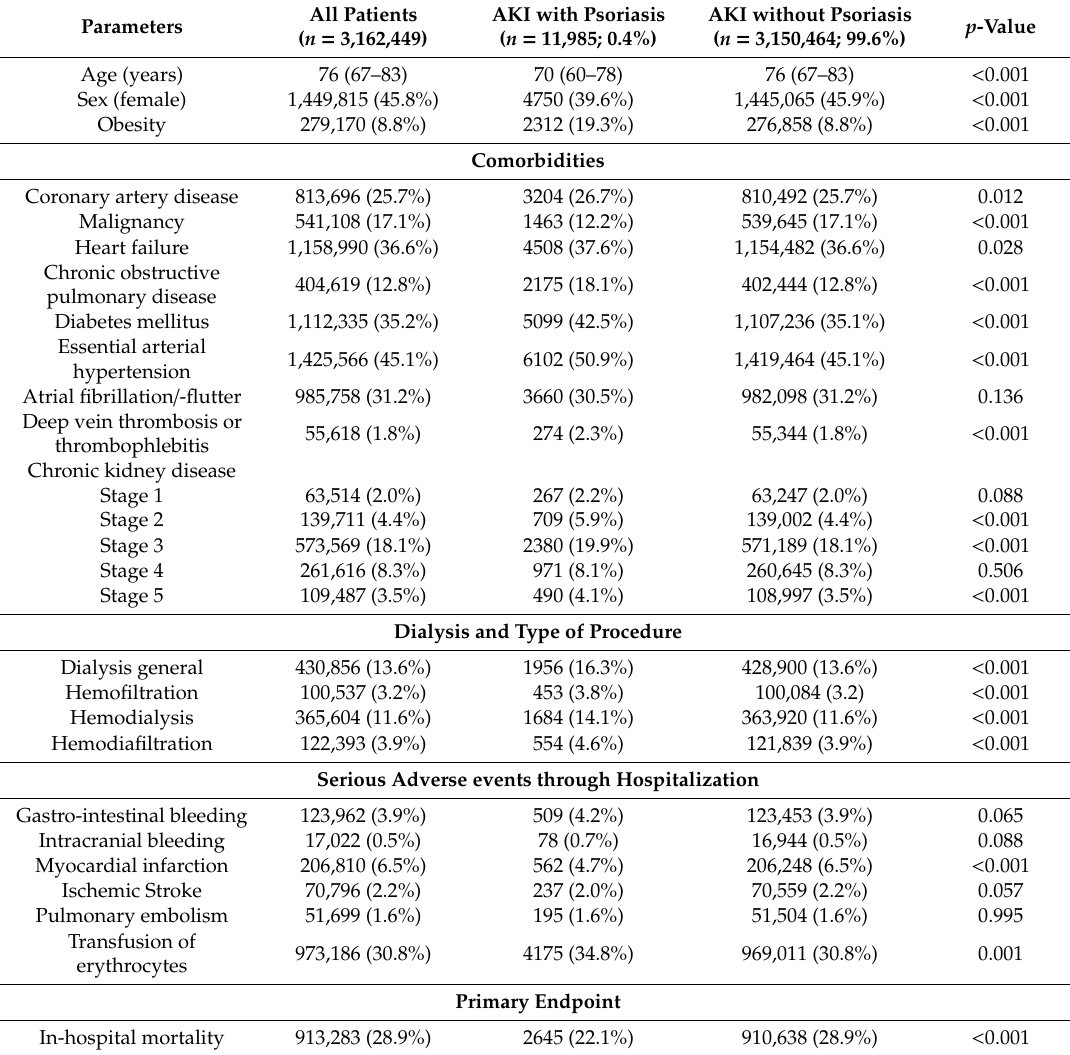
Table 1. Baseline characteristics, treatment, and outcome of patients with acute kidney injury (AKI) stratified by concomitant psoriasis (cumulative data of the years 2005–2016). All Patients Parameters ( n =